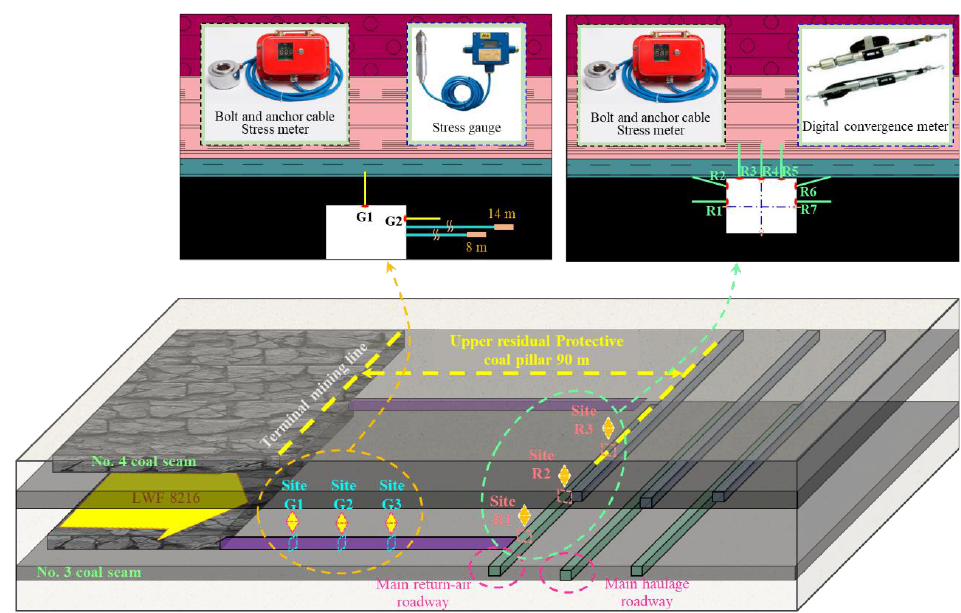
Figure 18. Ground pressure monitoring arrangement.